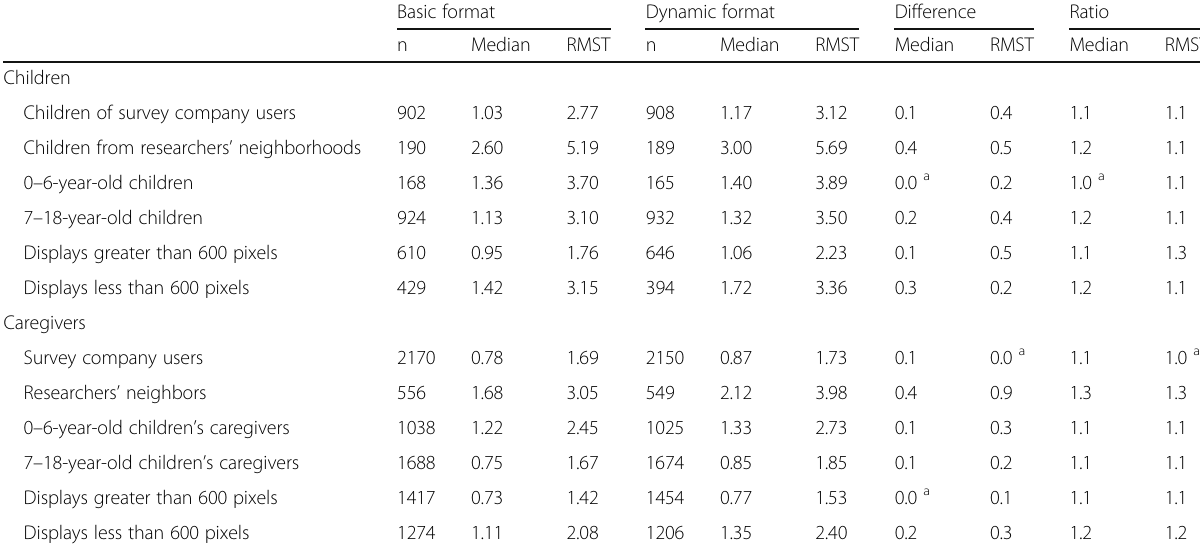
Table 3 Survey completion time (minutes) of two formats of the